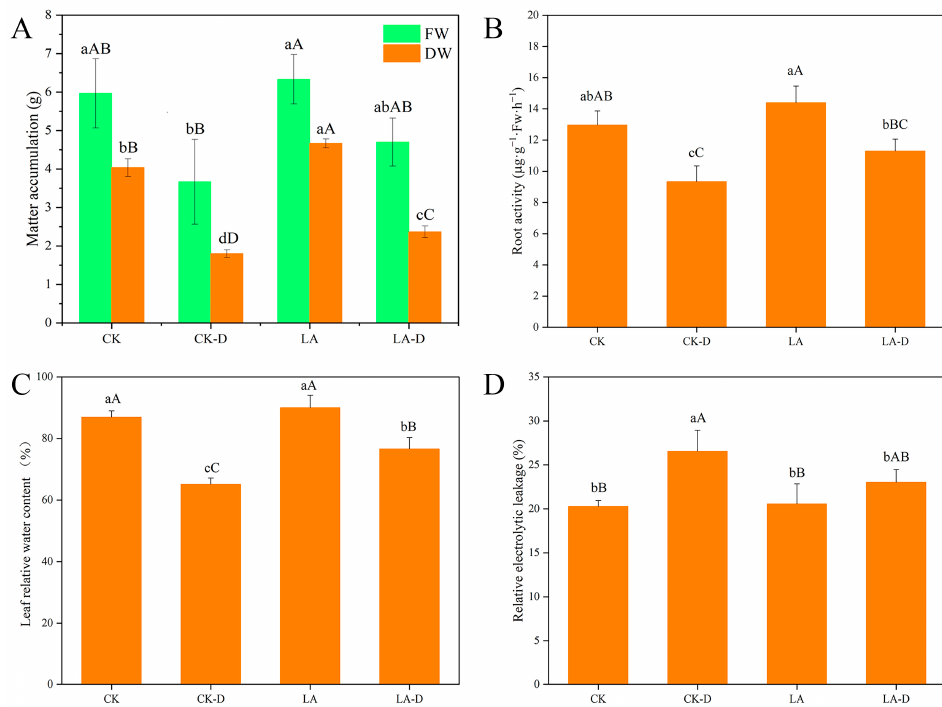
Figure 1. The e ff ects of LA on P. persica growth under drought stress. Determination of dry and fresh weight of P. persica treated with LA under drought condition ( A ), determination of root activity ( B ). The effects of LA treatments on relative water content ( C ) and relative electrolyte leakage ( D ) in leaves under control and drought circumstances are shown in the graphs, while different small letter superscripts mean significant difference ( p < 0.05), and different capital letter superscripts mean signi fi cant di ff erence ( p < 0.01). The same as below.